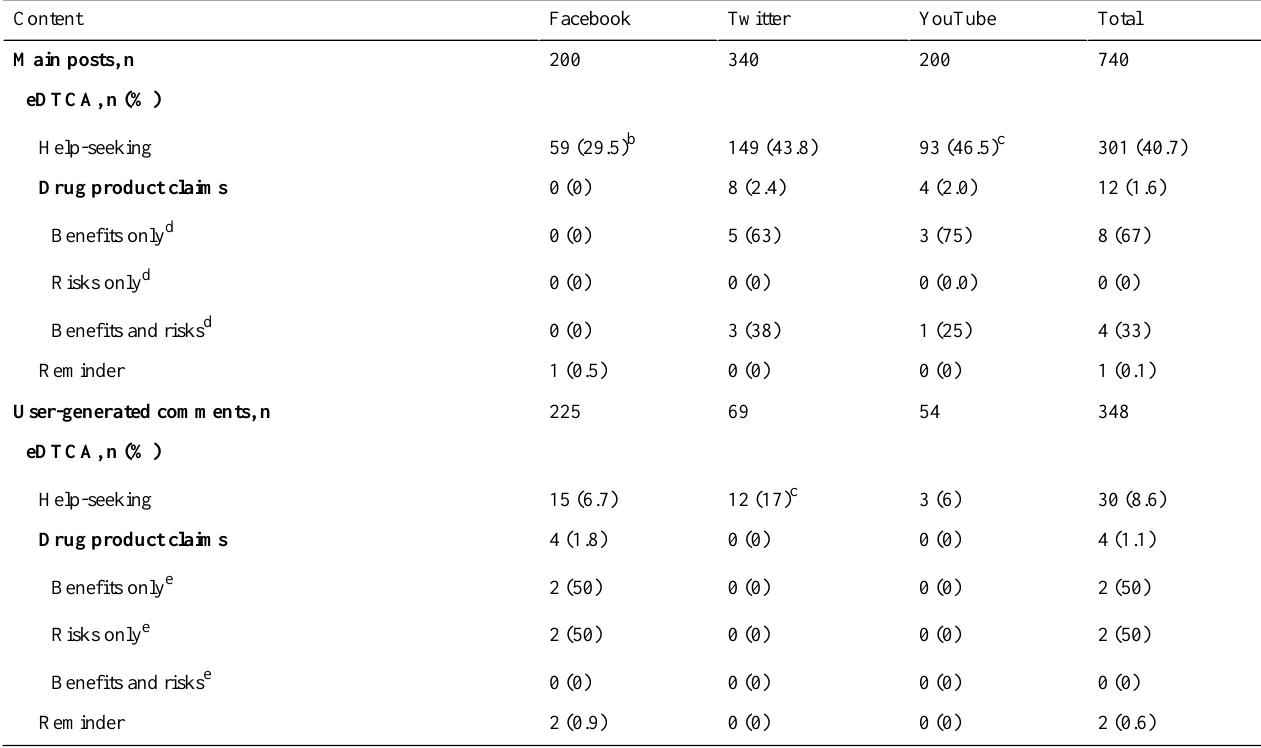
a Percentages in table based on column N, except where noted. b Statistically underrepresented in sample. c Statistically overrepresented in sample. d Percentages based on drug product claim posts only (n=12). e Percentages based on drug product claim comments only